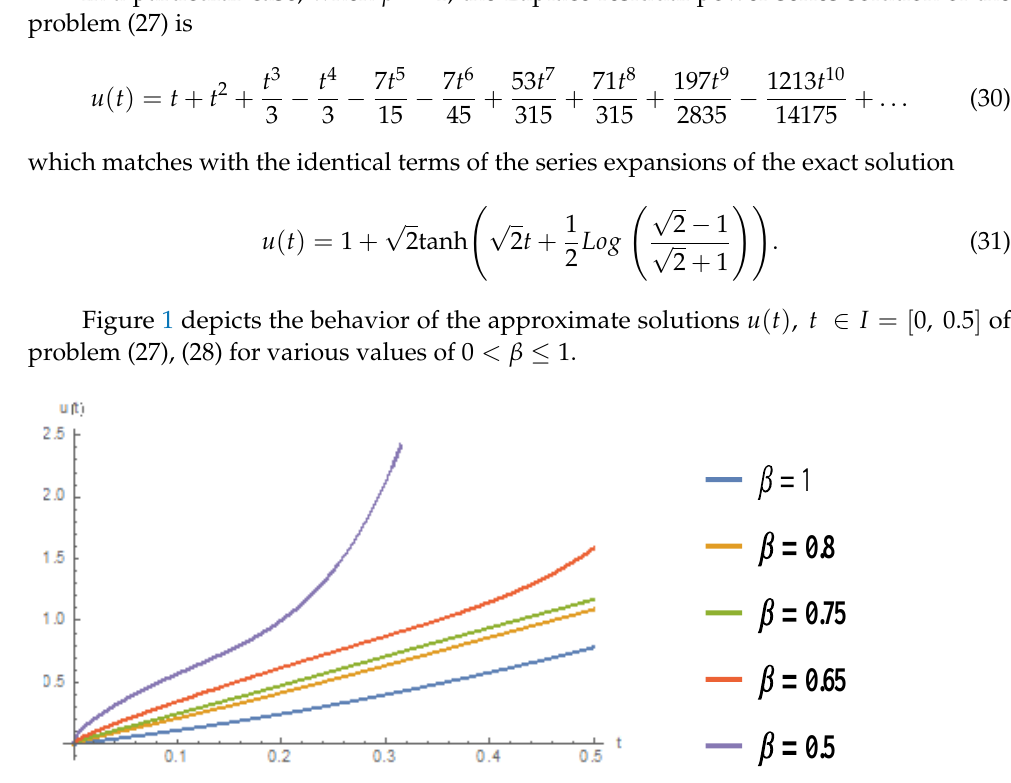
Figure 1. The behavior of the approximate solutions 𝑢(𝑡),𝑡 ∈ 𝐼 = [0,0.5] of problem (27) and (28).